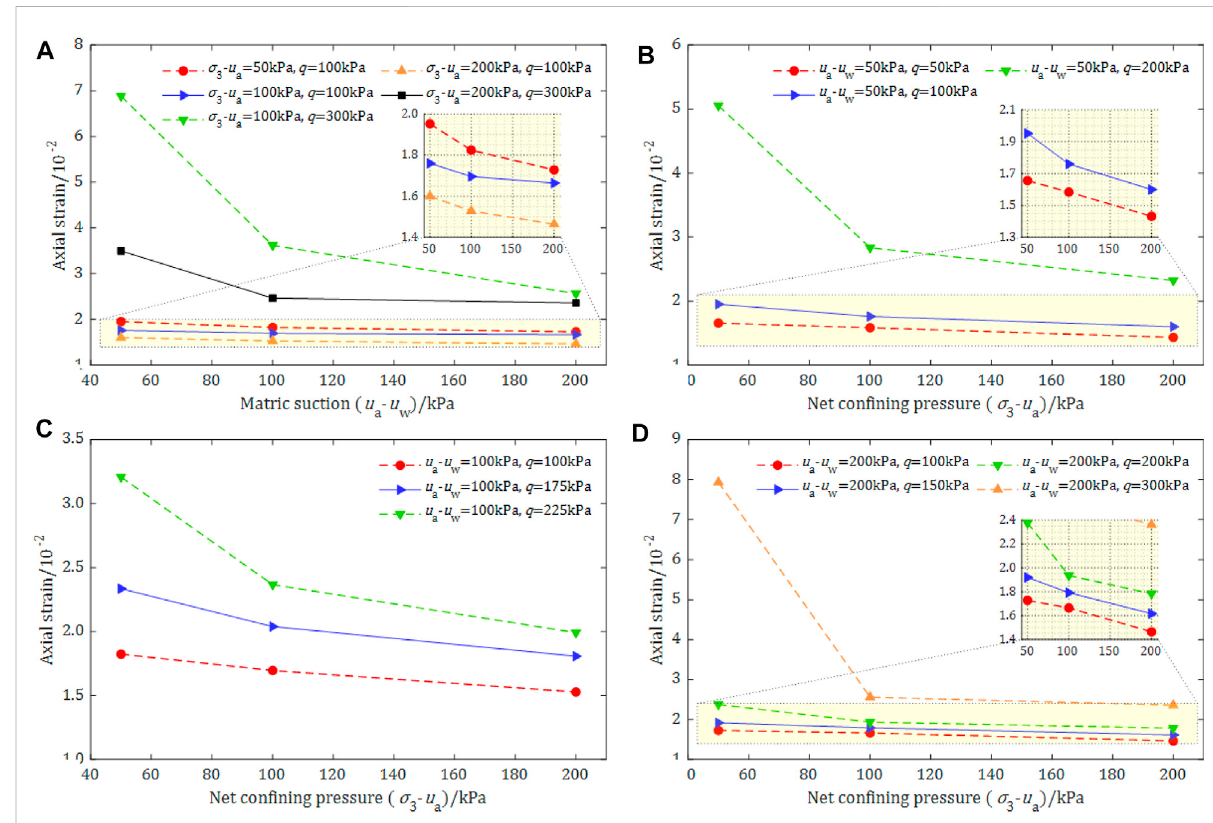
FIGURE 6 Finalcreepvaluecomparison underdifferentstressconditions. (A) The effect ofmatric suctionon axial strain; (B – D) The effectof netcon fi ning pressure on axial